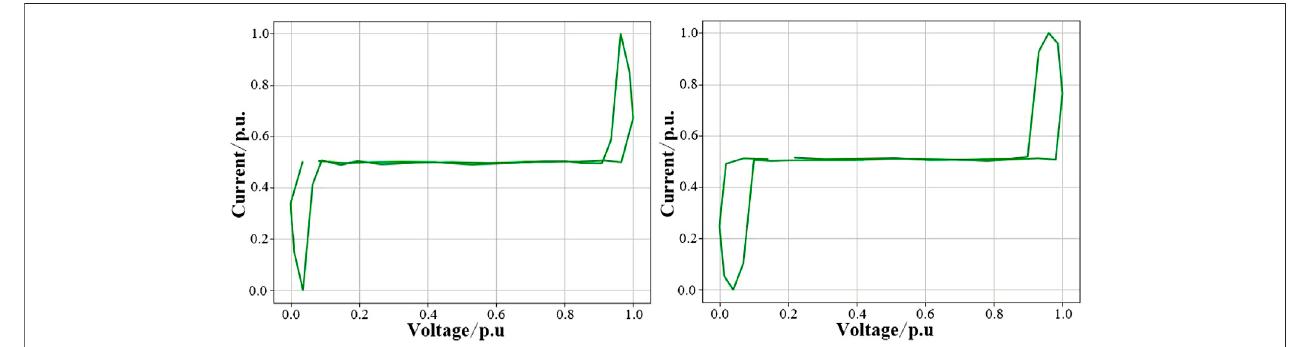
FIGURE 5 | V – I trajectories of two kinds of collected electric bicycles.